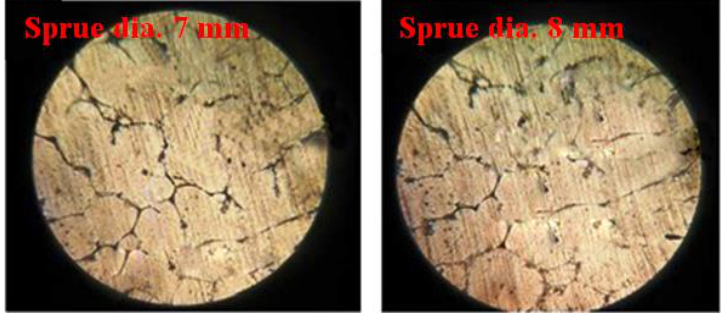
Figure 4. Optical images of counter gravity cast samples